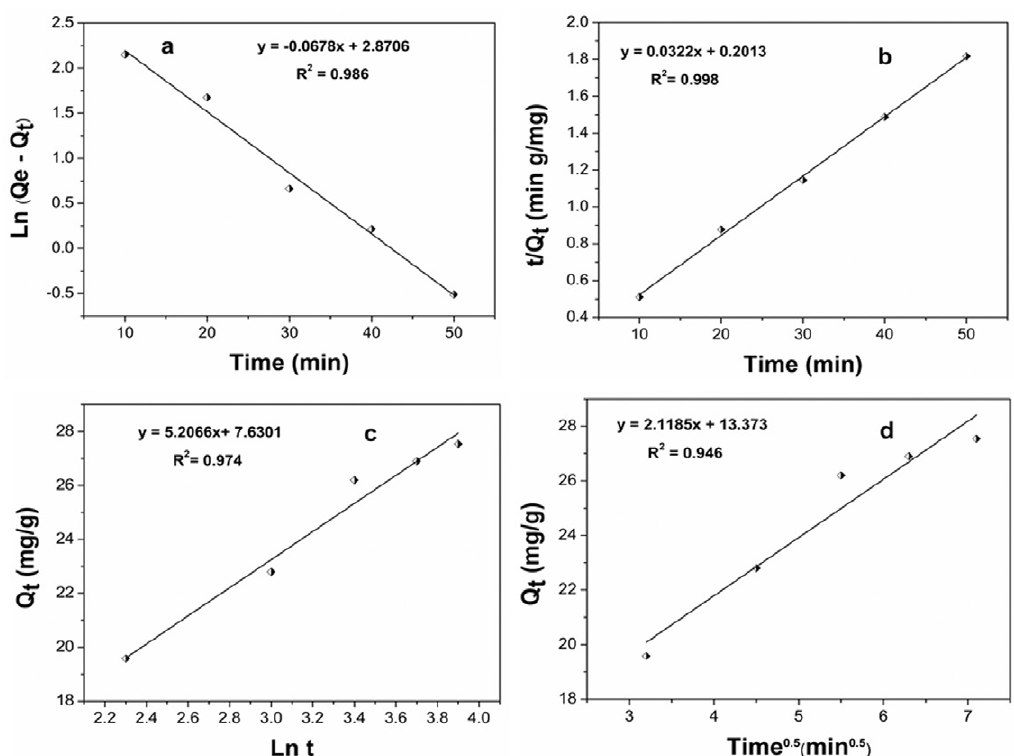
Fig. 11. Pseudo-first-order (a), pseudo-second-order (b), Elovich (c) and intraparticle diffusion (d) models for Mn (II) adsorption on Ac-OFIP ad-